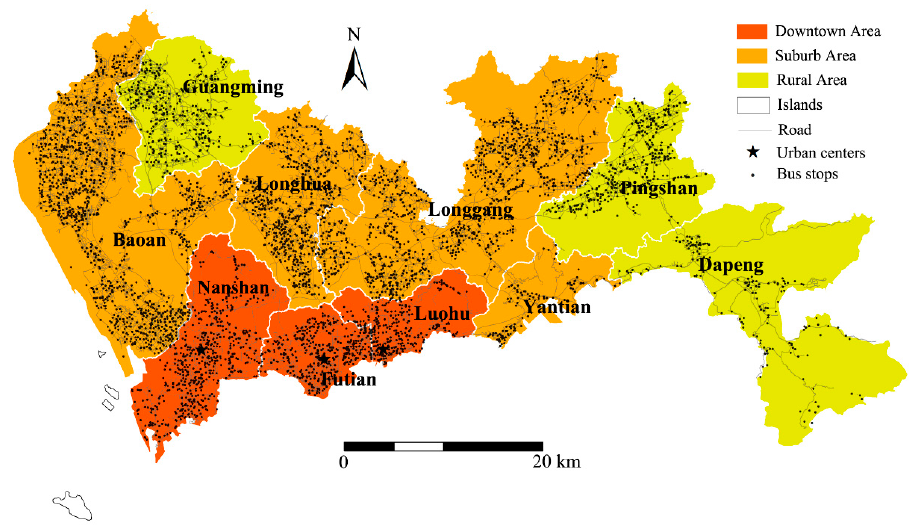
Figure 1. Study area and bus stops.